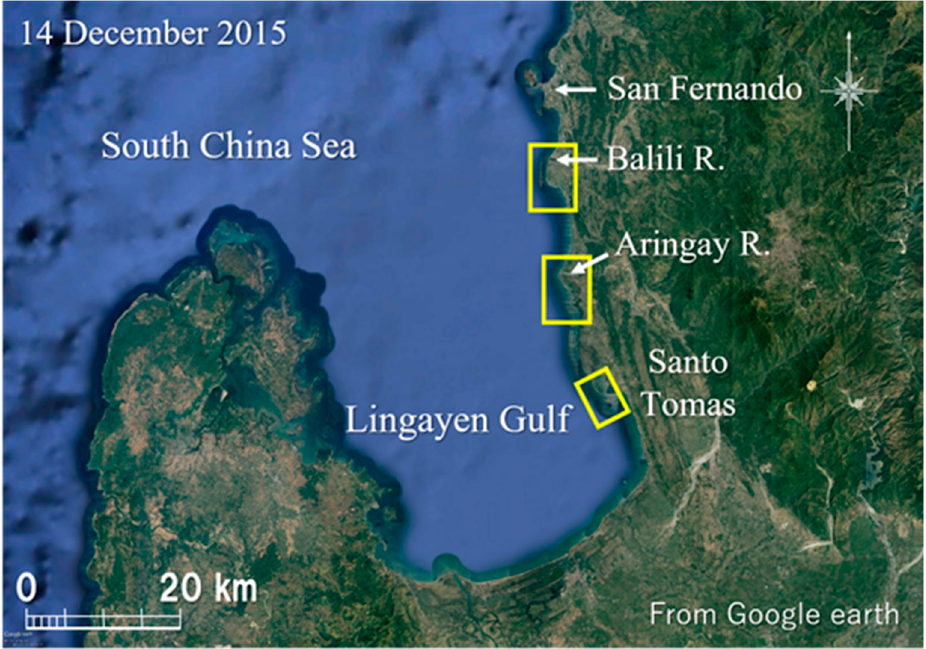
Figure 1. Satellite image of Lingayen Gulf (for location, 16°30 ′ 45.27 ″ N, 120°7 ′ 11.62 ″ E).